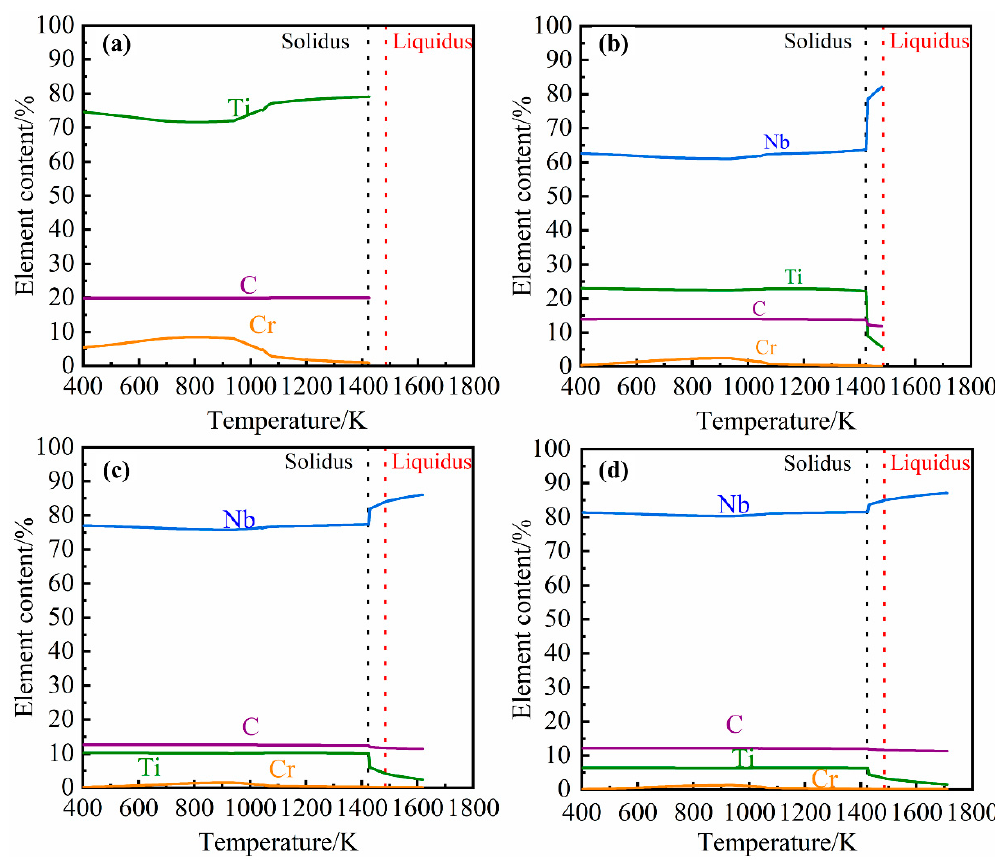
Figure 5. Relationship between MC-type carbide precipitate composition and temperature and alloy niobium content. ( a ) 0% Nb; ( b ) 0.098% Nb; ( c ) 0.27% Nb; ( d ) 0.46% Nb.